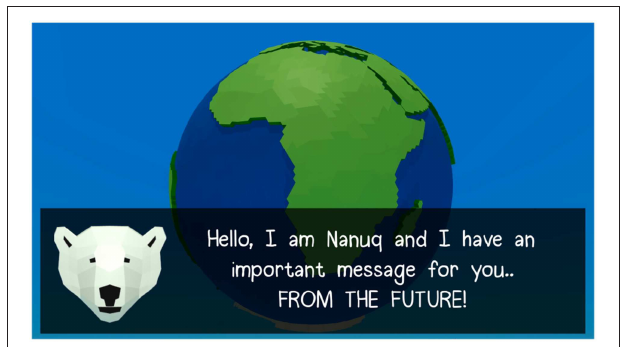
FIGURE 1 | On Thin Ice’s narrative element (Bianco, 2018a).